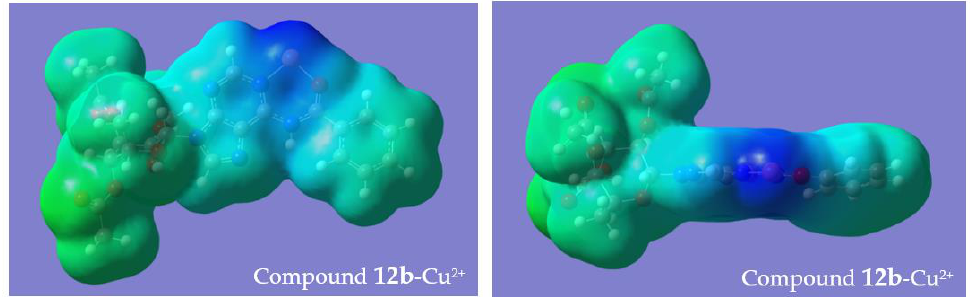
Figure 7. Different views of the molecular electrostatic potential surfaces for complex 12 b-